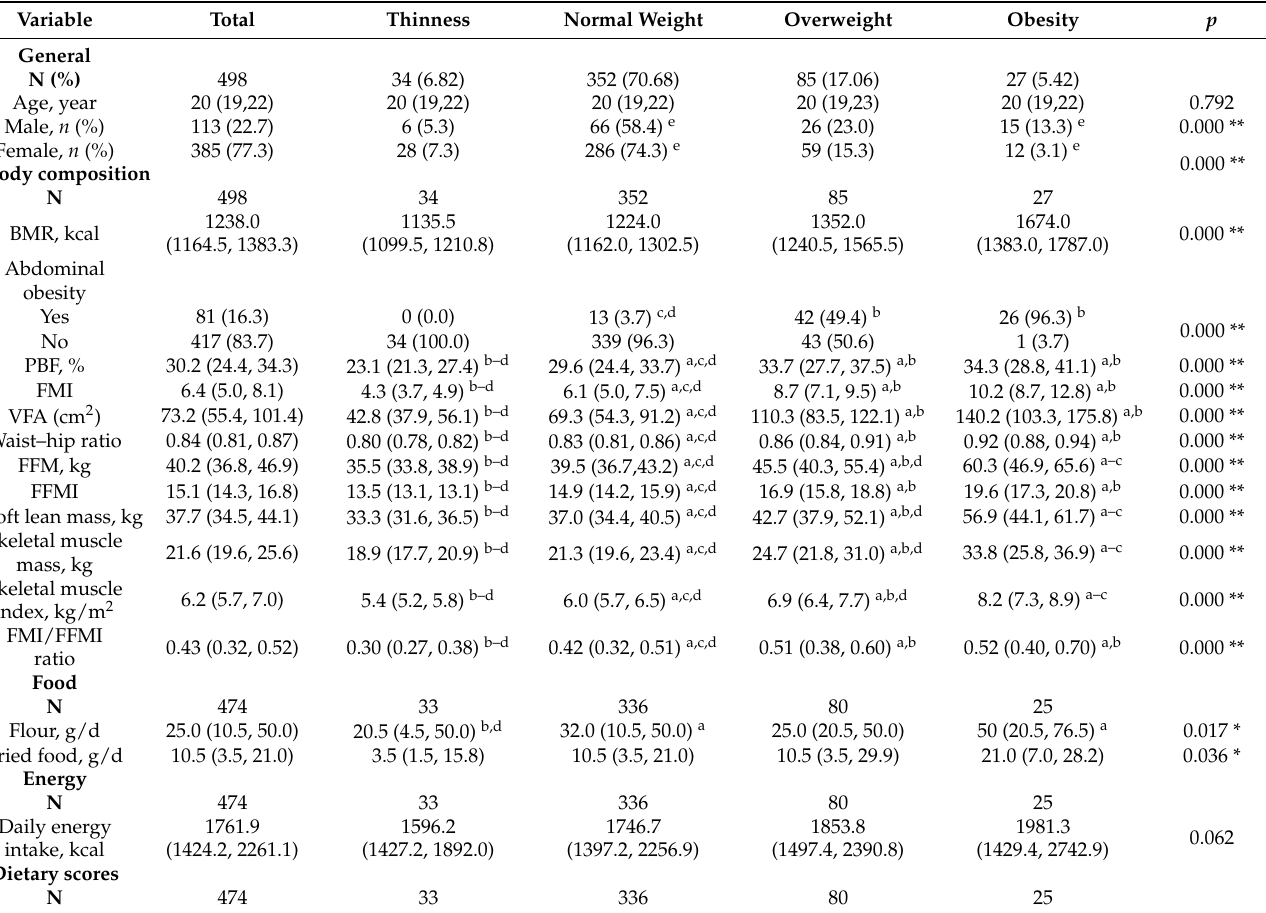
Table 1. Overall sample characteristics stratified by